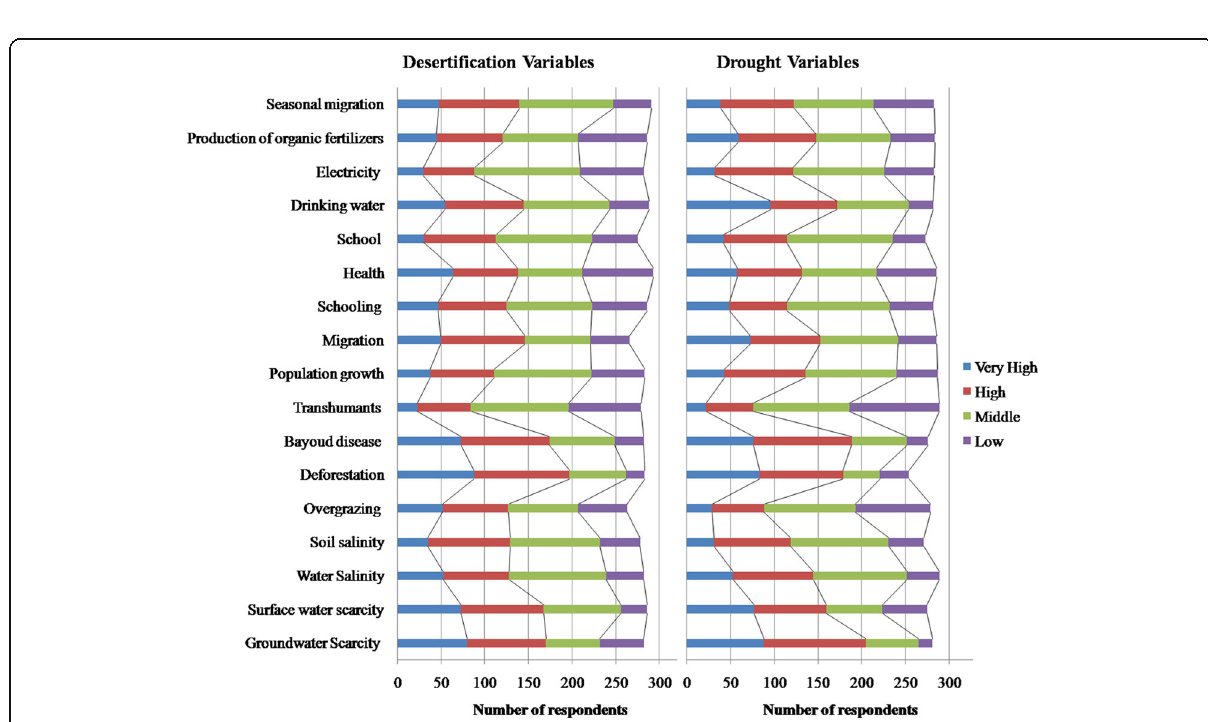
Fig. 6 Desertification and drought variables according to the